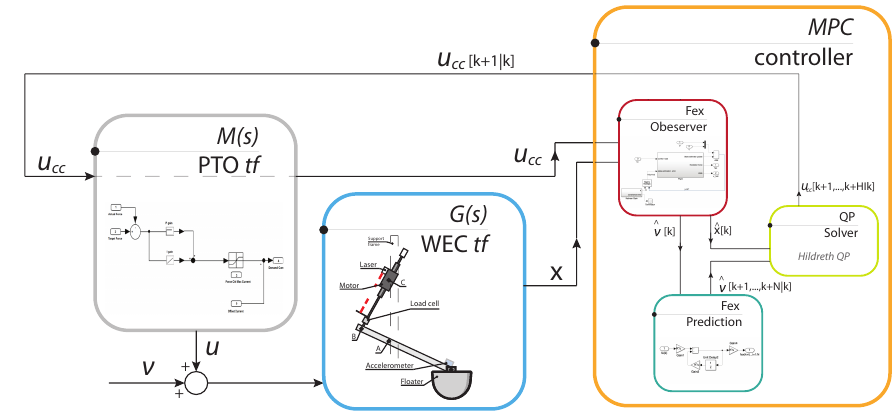
Figure 8. Block-diagram of the complete numerical model and detailed description of the controller